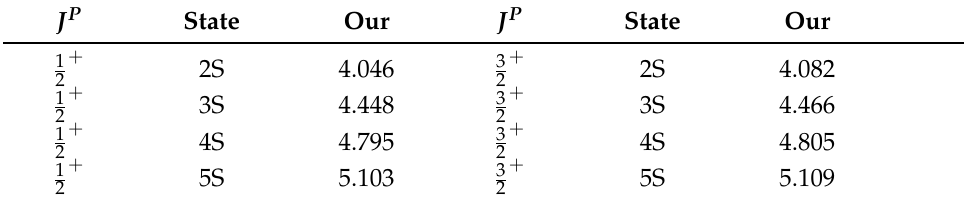
Table 2. Radial excited state masses (in GeV).